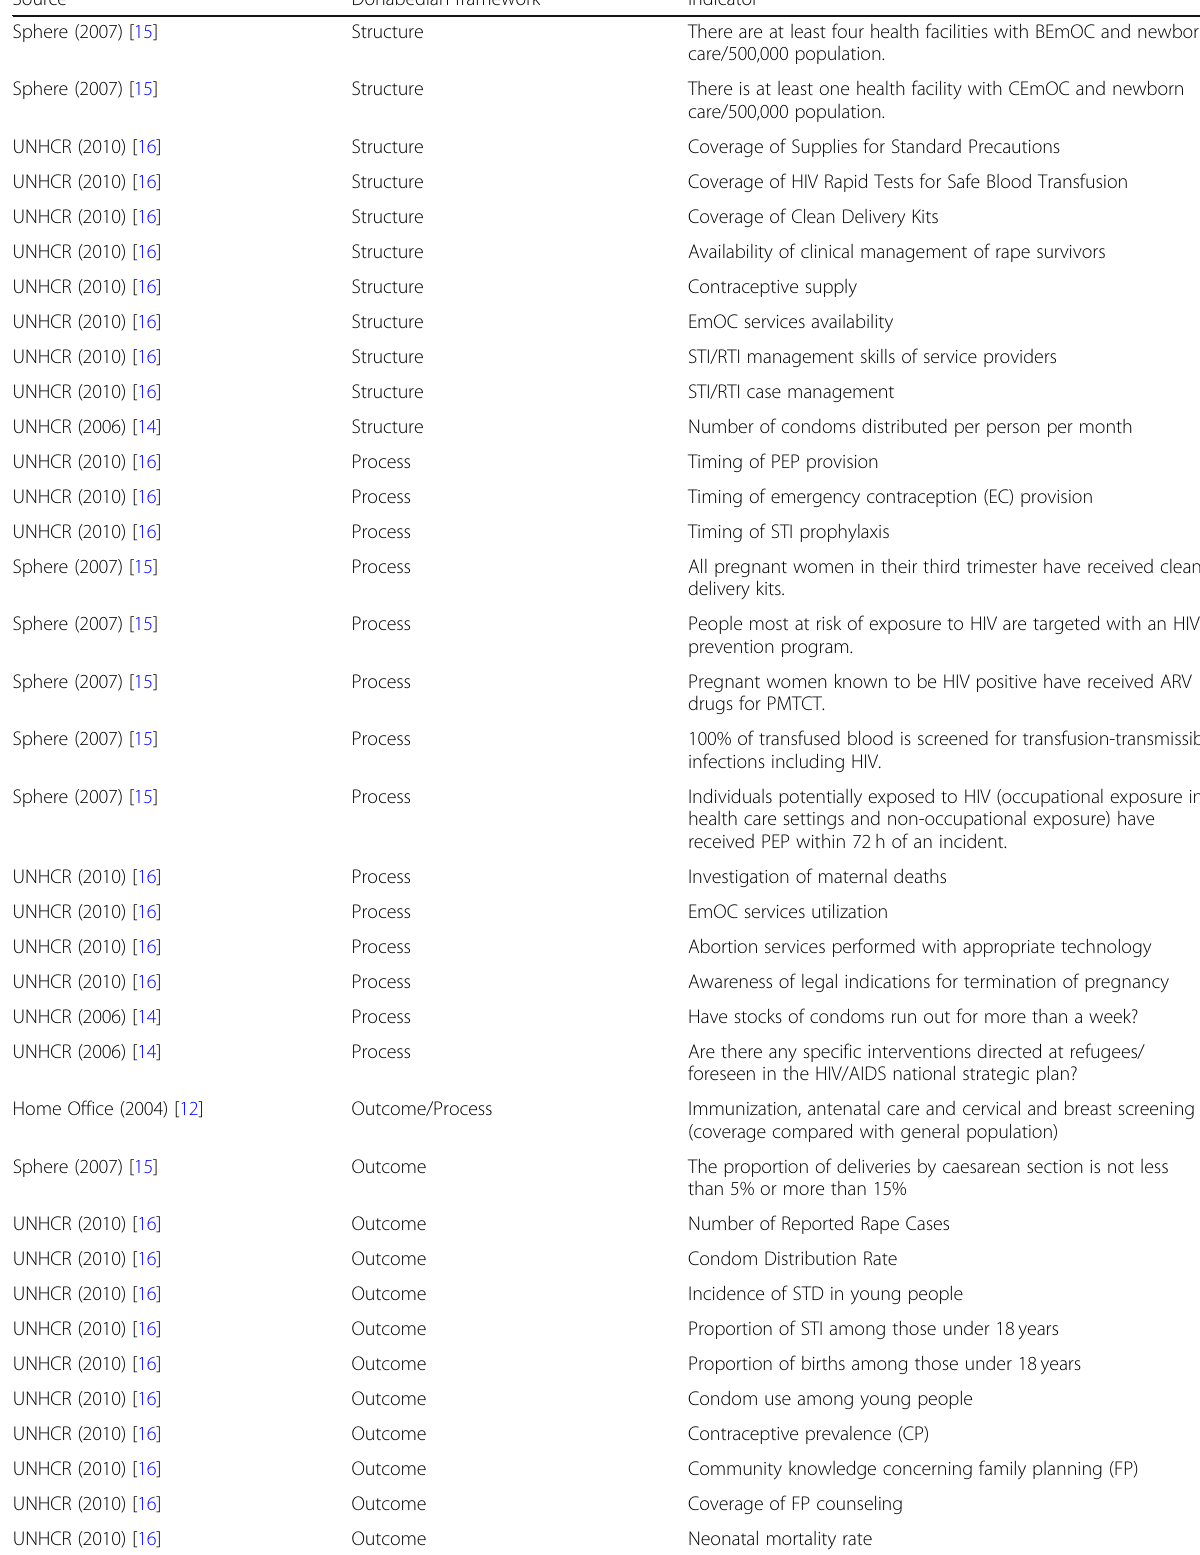
Table 2 Indicators of the topic reproductive